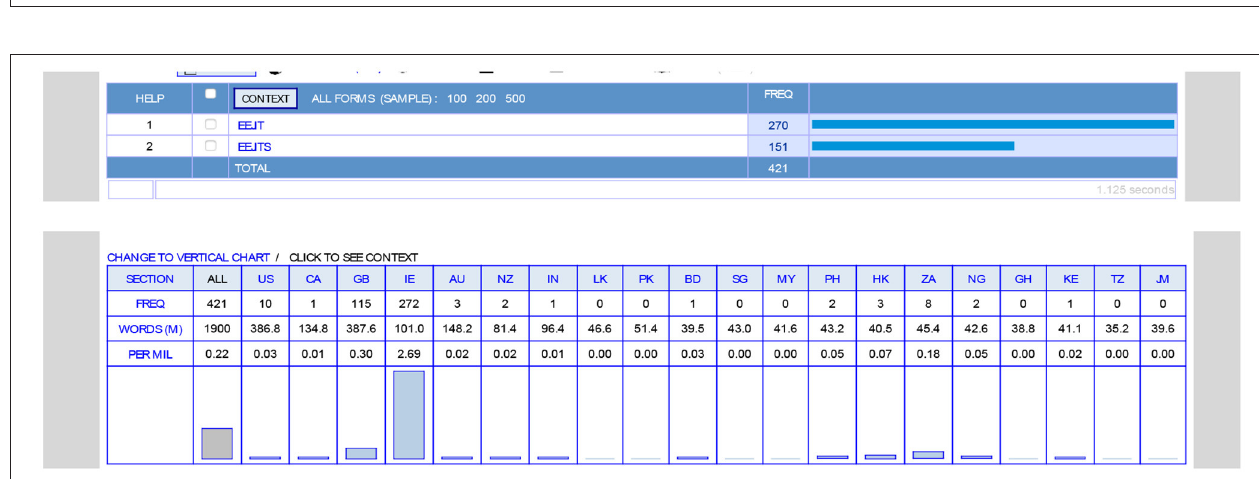
Frontiers in Communication |